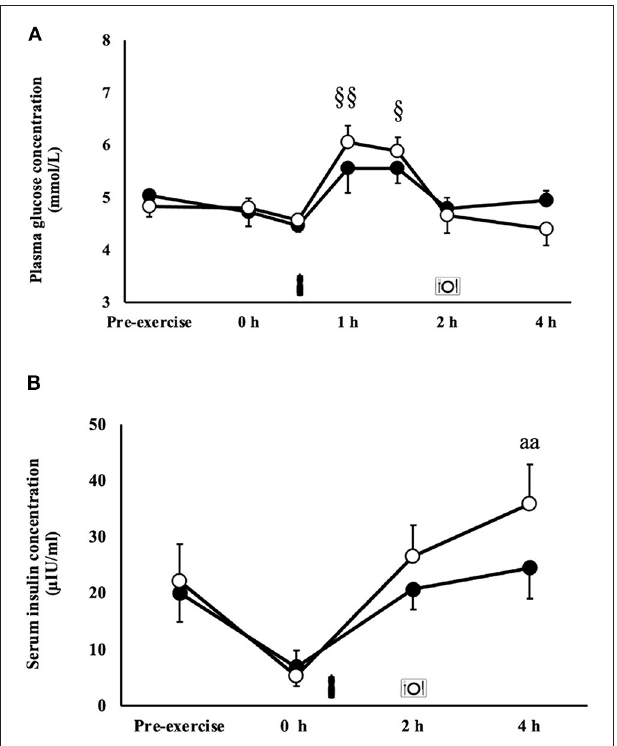
FIGURE 3 | Blood glucose (A) and serum insulin (B) concentrations after 2h HIIT exercise protocol in temperate ambient conditions and consumption of a whole food dairy milk (CM: (cid:4) ) and a reconstituted milk based supplement (MBSB: ◦ ) recovery beverage. Mean ± SEM ( n = 9): aa P < 0.01 vs. CM. MEOTime §§ P < 0.01 vs. pre-exercise and § P < 0.05 vs. pre-exercise.